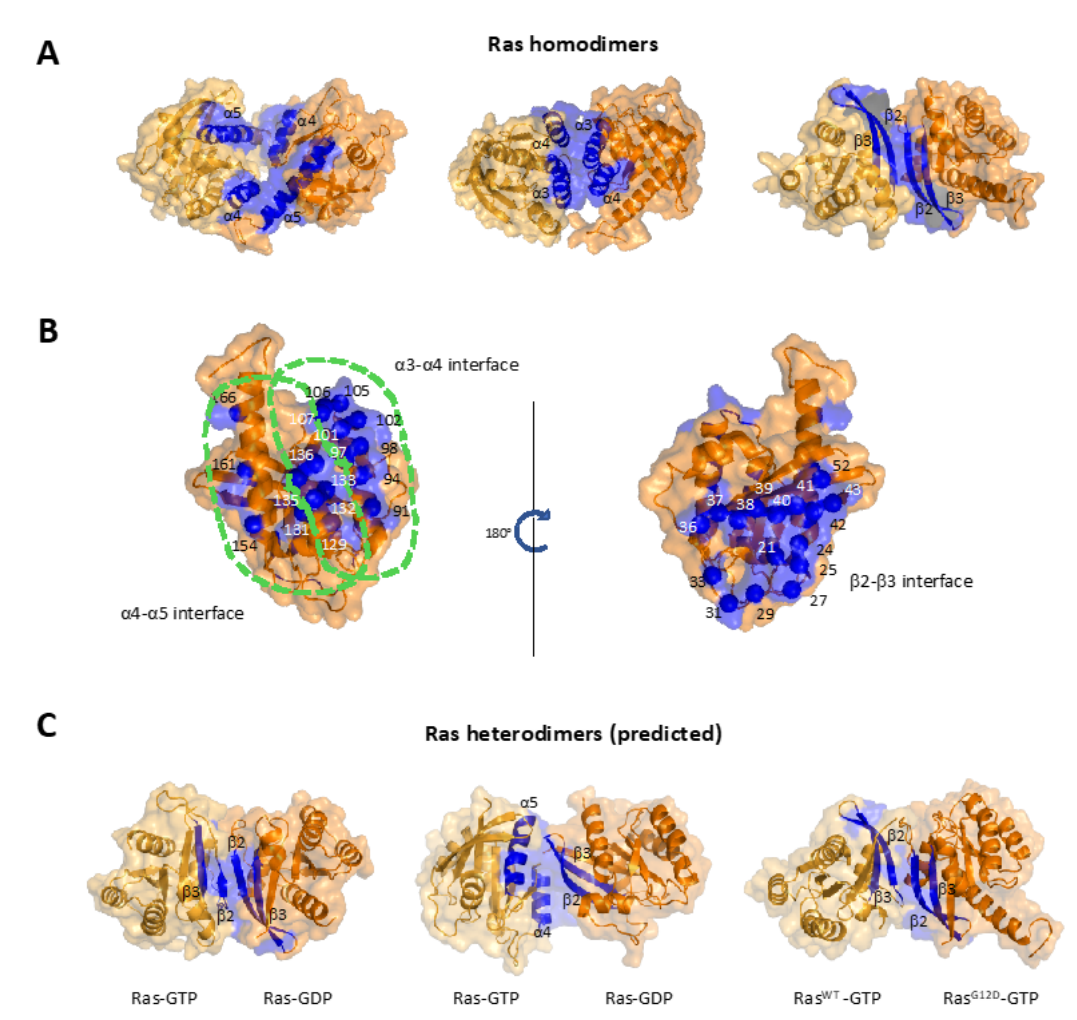
Figure 3. Various Ras G-domain dimer interfaces. ( A ) Three common interfaces identified by computational and experimental studies. These major interfaces can be classified as the α 4- α 5 interface (left panel), the α 3- α 4 interface (middle panel), and the β 2- β 3 interface (right panel). Blue regions indicate dimerization interfaces, two identical KRas monomers are colored with two shades of orange for the sake of visual clarity. ( B ) Mapping interface residues for all three dimer interfaces shown in ( A ) on the Ras G-domain, with the left showing those for the α 4- α 5 and α 3- α 4 interfaces and the right showing those for the β 2- β 3. ( C ) Predicted heterodimer interfaces. Left and middle panels are two predicted HRas-GTP/HRas-GDP heterodimer structures, featuring symmetric β -interface (left) and an asymmetric α - β interface (middle). On the right is a predicted structure for a KRas G12D-GTP/ KRas WT-GTP heterodimer. Predictions are made based on the methods described in Muratcioglu et al.